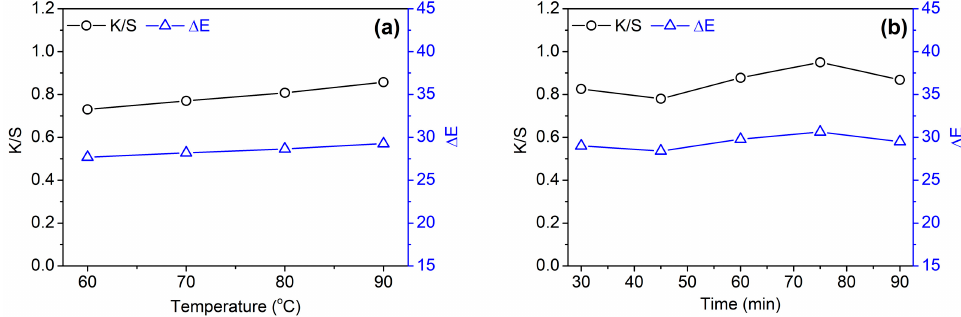
Figure 4. E ff ects of temperatures ( a ) and time ( b ) on the color depth (K / S at 450 nm) and color di ff erence Figure 4. Effects of temperatures ( a ) and time ( b ) on the color depth (K/S at 450 nm) and color of cotton fabrics dyed with 20%owf GSE. difference of cotton fabrics dyed with 20%owf GSE.